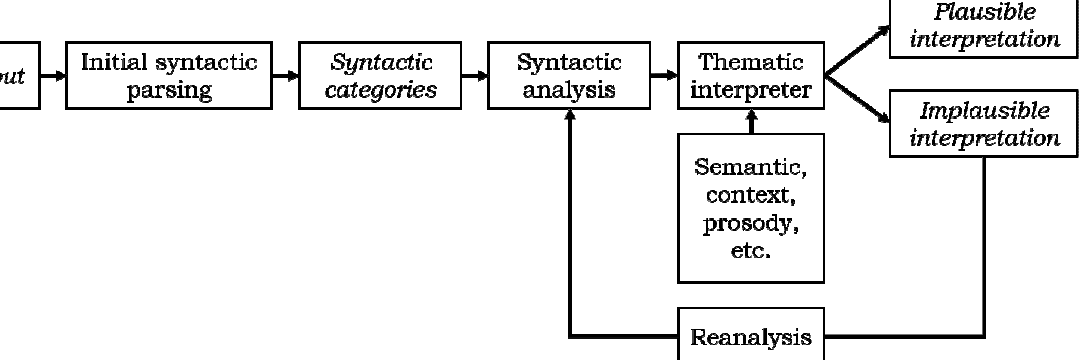
Figure 1. Garden-path